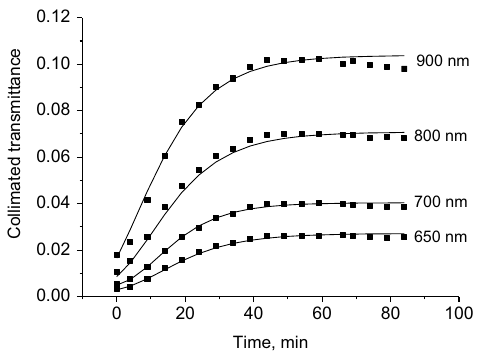
Fig. 2. The experimental (dots) and calculated (lines) time dependences of collimated transmittance of the myocardium sample placed in the 40%-glucose